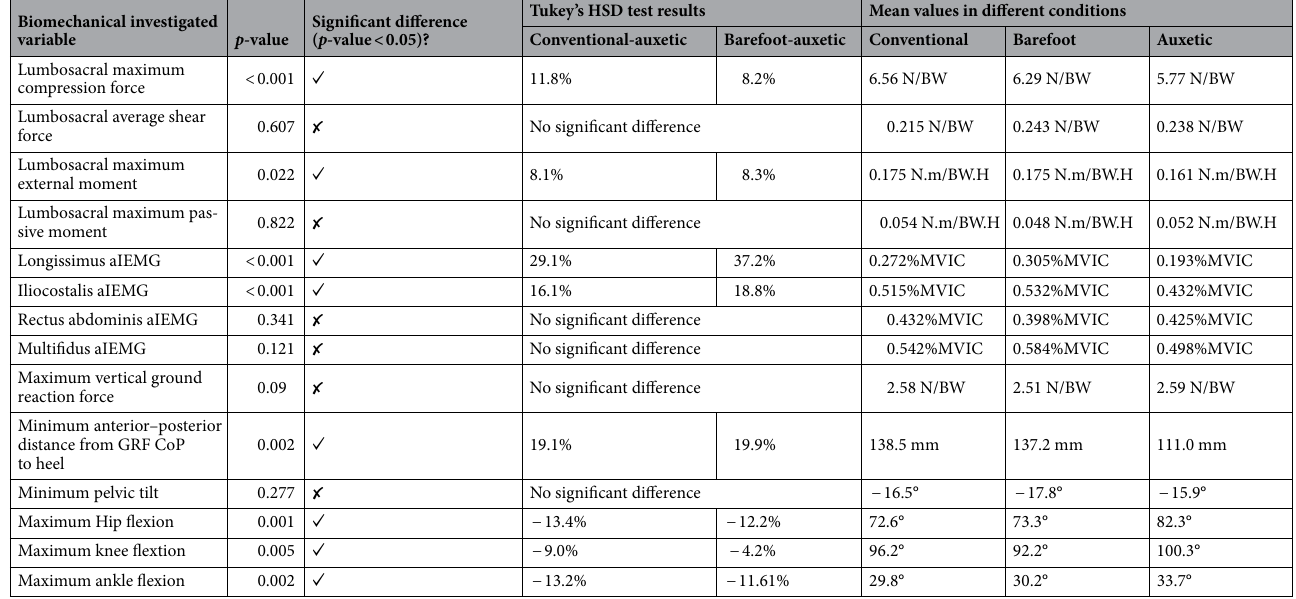
Table 1. Effects of different footwear conditions on various biomechanical parameters during the FL phase of DVJ based on ANOVA and Tukey’s tests.